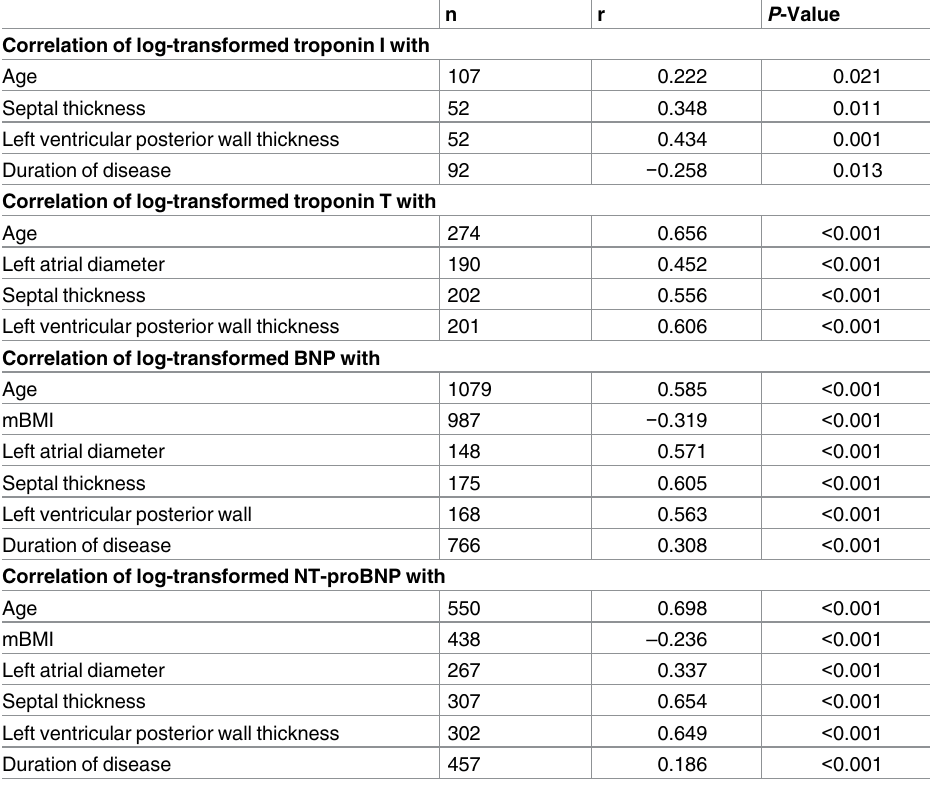
were 4 (6.5%), 9 (14.5%), 21 (33.9%), and 28 (45.2%) deaths in Q1, Q2, Q3, and Q4, respec- tively. Three-year overall survival estimate for the patients below the optimal cut-point for BNP/NT-proBNP was 98.1% ± 0.6% and was 70.1% ± 3.1% for patients above the optimal cut- point, with significant difference between the two survival curves (p < 0.001). Three-year over- all survival estimate for the three BNP/NT-proBNP quartiles Q1 to Q3 combined was 95.8% ± 0.8% and of Q4 was 65.2% ± 3.9%, with significant difference between the two survival curves (p < 0.001). Three-year overall survival estimate for the patients below the optimal cut-point for troponin T/I was 88.6% ± 5.0% and was 43.6% ± 6.0% for patients above the optimal cut- point, with significant difference between the two survival curves (p < 0.001). Three-year over- all survival estimates for troponin T/I quartiles Q1 to Q3 combined was 73.7% ± 4.8% and of Q4 was 32.5% ± 8.0%. There was a significant difference between the two survival curves (p < 0.001). By combination of both biomarkers, stepwise risk stratification was achieved (Stage A: both natriuretic peptides AND troponins above; Stage B: both natriuretic peptides AND troponins below; Stage C: either of natriuretic peptides OR troponins is above. Kaplan-Meier curves were produced for patients grouped by optimal cut-off values for natriuretic peptides (Fig 2) and the combination of both biomarkers (Fig 3). Results from the univariate analyses are presented in Table 4. Based on these results, age, gender, mBMI, duration of disease, estimated glomerular filtration rate (eGFR), and Val30- Met/non-Val30Met were included in the multivariate Cox proportional hazards model. By multivariate analysis age [hazard ratio (HR) 1.062, 95% confidence interval (CI) 1.062–1.086],